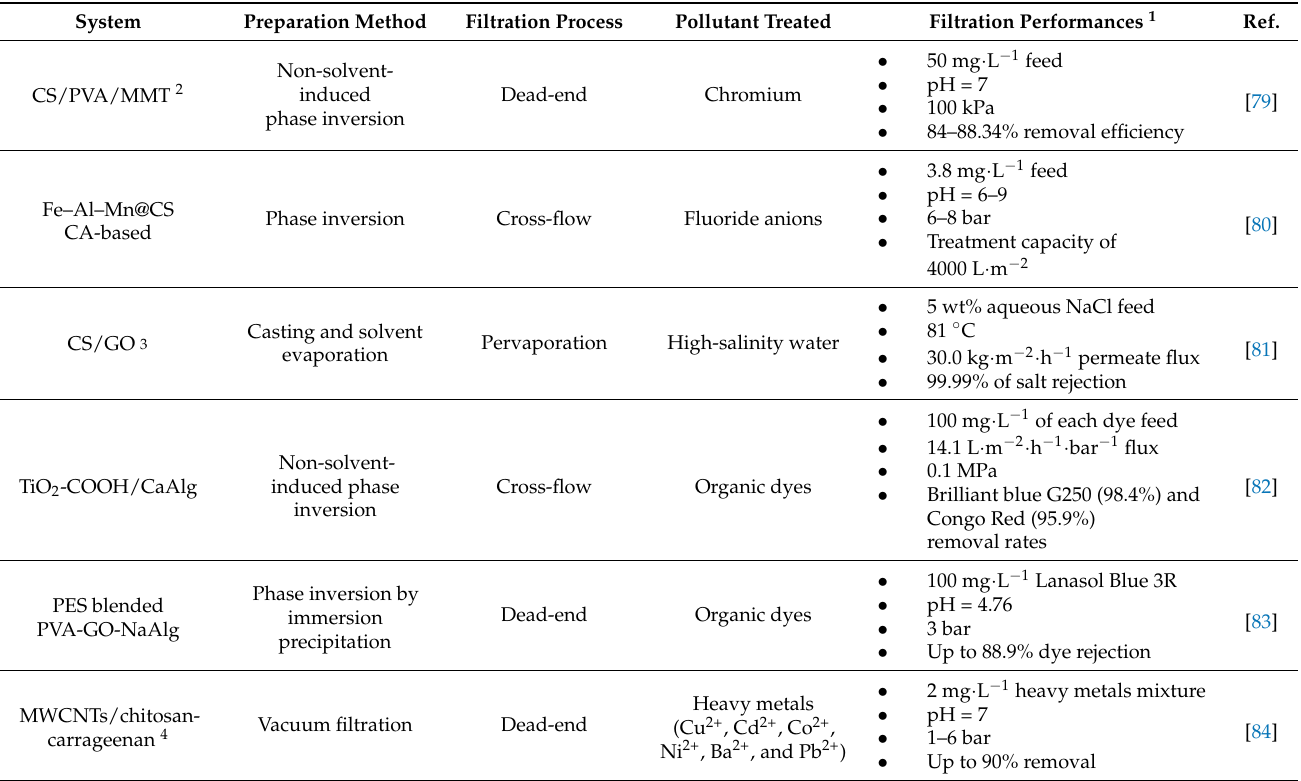
Table 3. Explicative table with reported a comparison of the most recent developed sustainable hybrid and polymer/gel mixed-matrix membranes.